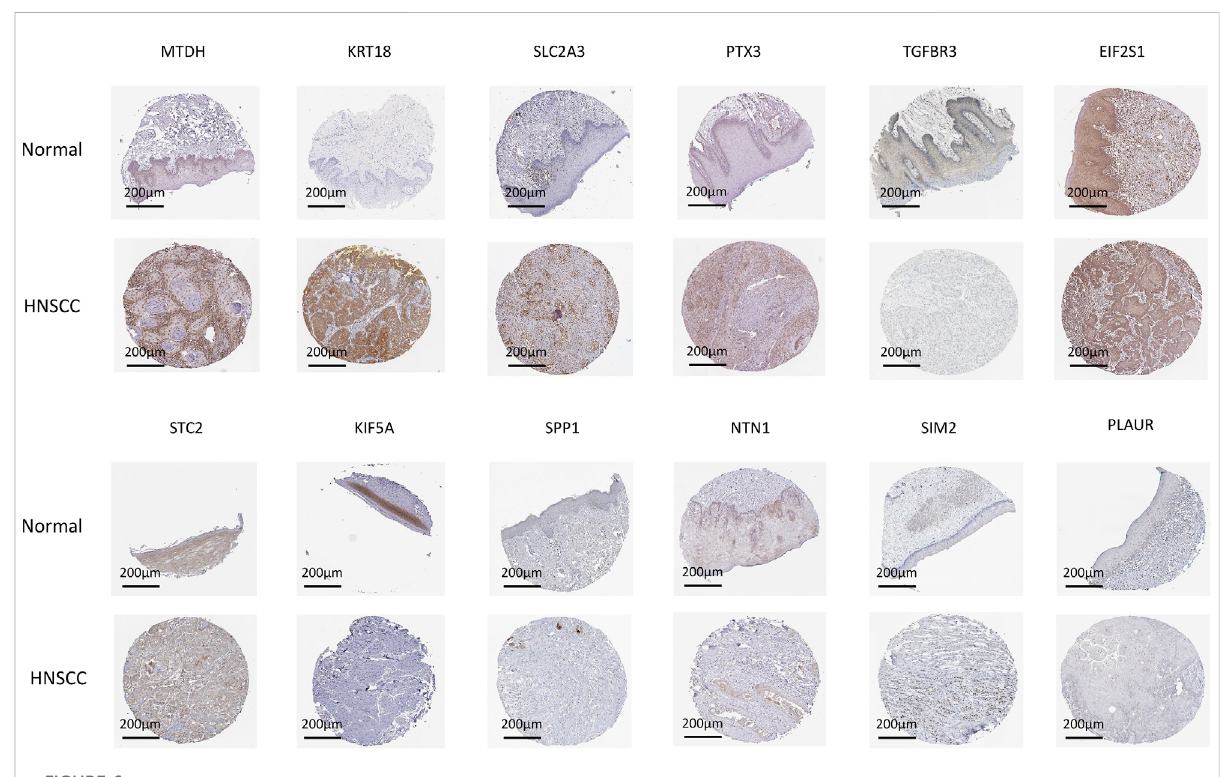
FIGURE 6 CIEH model immunohistochemistry validation. Using theHPA database, weanalyzedthe expression of related target proteins innormal tissues and